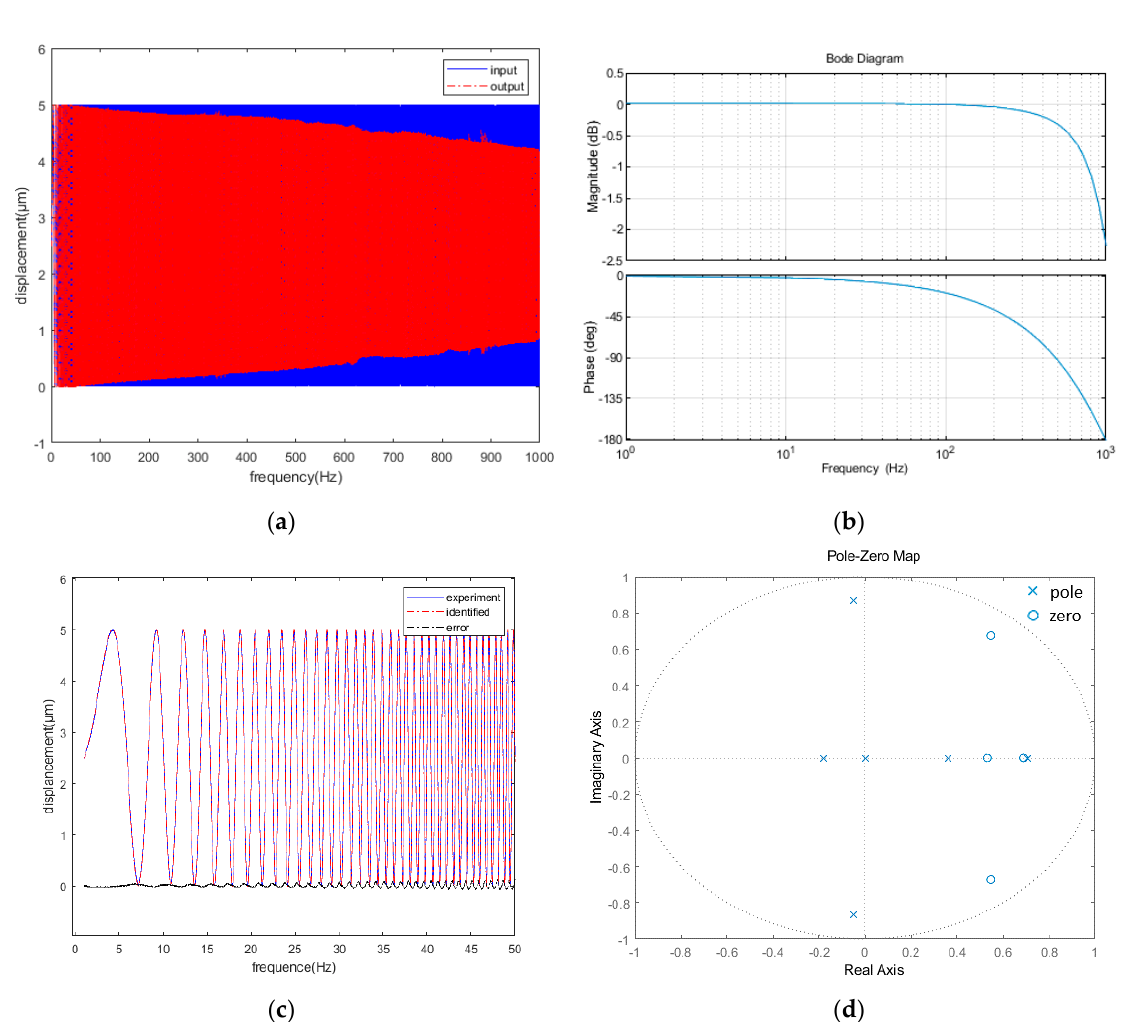
Figure 10. ( a ) Sweep signal at 0–1000 Hz frequency; ( b ) Bode diagram of the closed-loop system; ( c ) identification results; ( d ) zero-pole distribution.